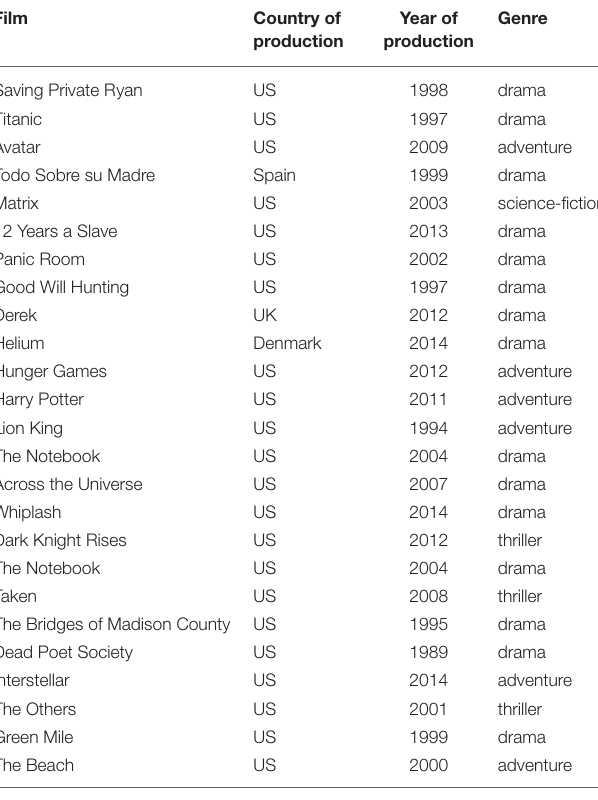
TABLE 2 | Chill-eliciting films and